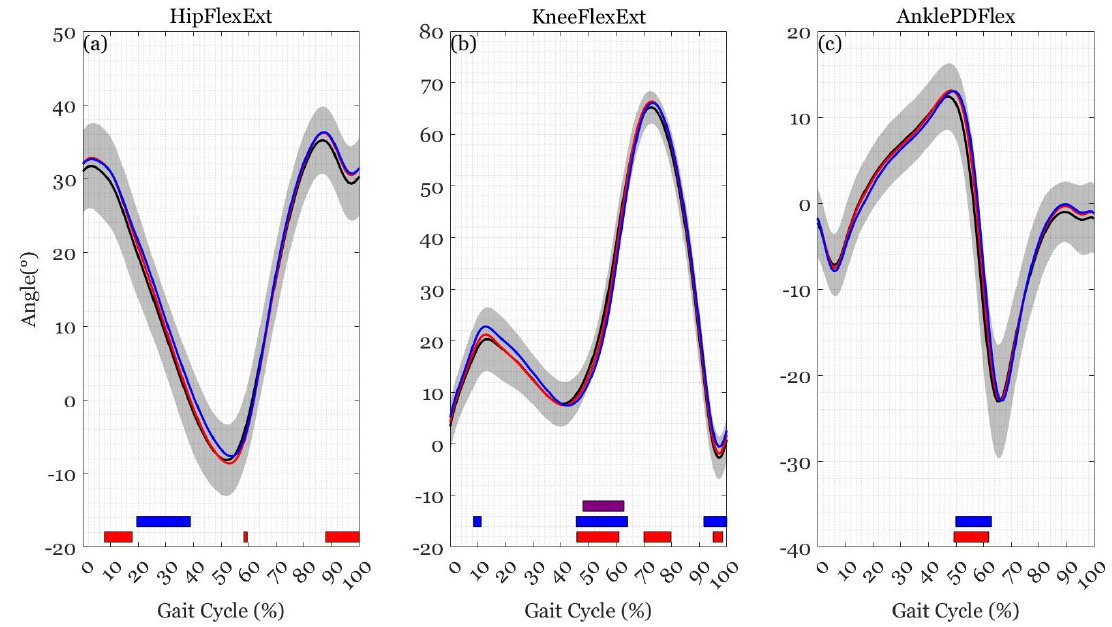
Figure 1. Mean trajectories for ( a ) hip joint flexion-extension angle, ( b ) knee joint flexion-extension angle, and ( c ) ankle joint plantar-dorsiflexion angle during load carriage of 0% BM (black), 20% BM (red), and 40% BM (blue). The colored bars show when the SPM { t } critical threshold was exceeded between 0% BM and 20% BM (red), 0% BM and 40% BM (blue), and 20% BM and 40% BM (purple).